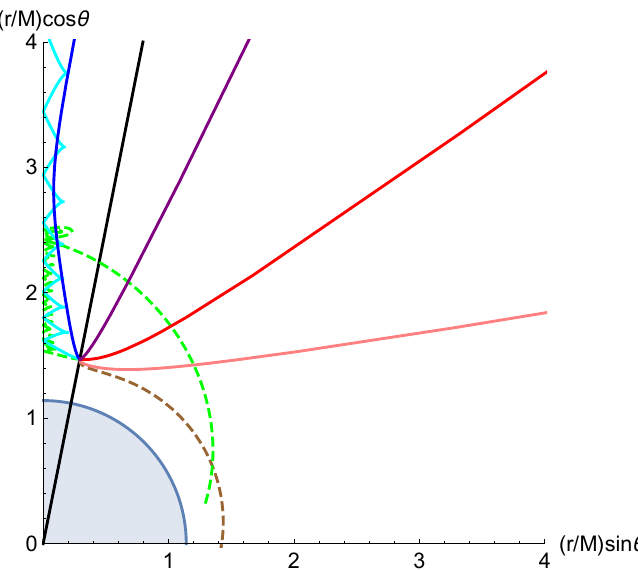
Figure 2. Examples of trajectories in ( r , θ ) plane near the Kerr black hole with a = 0.99 M. All trajec- tories start from the initial position ( r 0 , θ 0 ) = ( 1.5 M, π /16 ) ; however, they depend on κ . The black straight line represents θ = θ 0 , and the blue quarter circle represents the